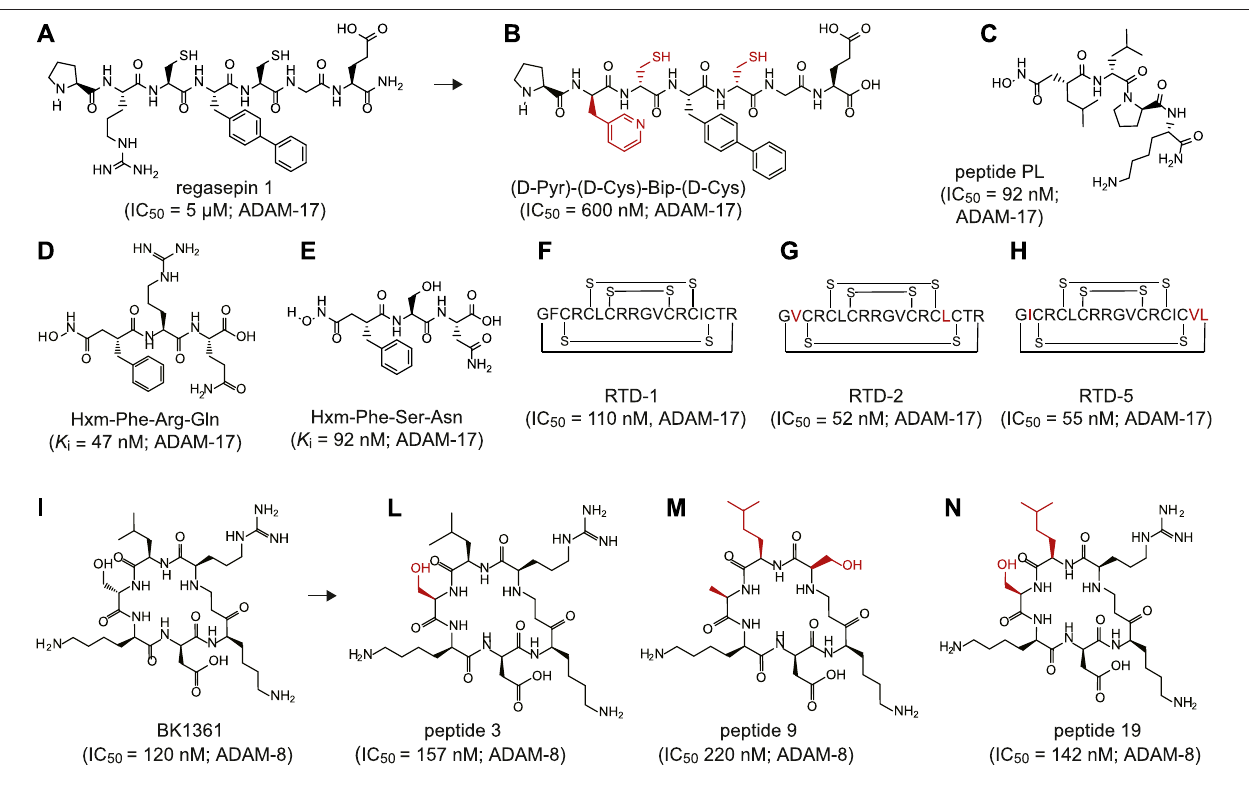
FIGURE1| PeptideinhibitorsofADAMproteins. (A) Chemicalstructureofregasepin1linearpeptide(PRC(Bip)CGE); (B) Chemicalstructureofregasepin1-derived linear peptide (D-Pyr)-(D-Cys)-Bip-(D-Cys); (C) Chemical structure of peptide PL (Hisb-LPK-NH2); (D) Chemical structure of linear peptide Hxm-FRQ; (E) Chemical structure of linear peptide Hxm-FSN; (F) Schematically depicted structure of polycyclic octadecapeptide rhesus θ -defensin-1 (RTD-1) peptide; (G) Schematically depictedstructure ofpolycyclic octadecapeptiderhesus θ -defensin-2(RTD-2)peptide; (H) Schematicallydepictedstructure ofpolycyclic octadecapeptiderhesus θ -defensin-5 (RTD-5)peptide; (I) ChemicalstructureofcyclicpeptideBK1361(RLsKDK); (L) Chemicalstructure ofcyclicpeptide3(RLhS β KDK); (M) Chemicalstructure ofcyclicpeptide9(RL*A β KDK); (N) Chemicalstructureofcyclicpeptide19(RL*hS β KDK).Indicatedhalfmaximalinhibitoryconcentration(IC 50 )andinhibitionconstant( K i) values were reported as published. The targeted ADAM protein is reported near the IC 50 or K i value. Legend: Bip (cid:2) biphenylalanine, Pyr (cid:2) pyridylalanine, Hisb (cid:2) (R)-2- isobutylsuccin hydroxamate moiety, Hmx (cid:2) hydroxamate moiety, s (cid:2) D-serine; hS β (cid:2) β -homoserine, A β (cid:2) β -alanine, L* (cid:2) homoleucine. The side chains that differentiate from the parental peptide are shown in